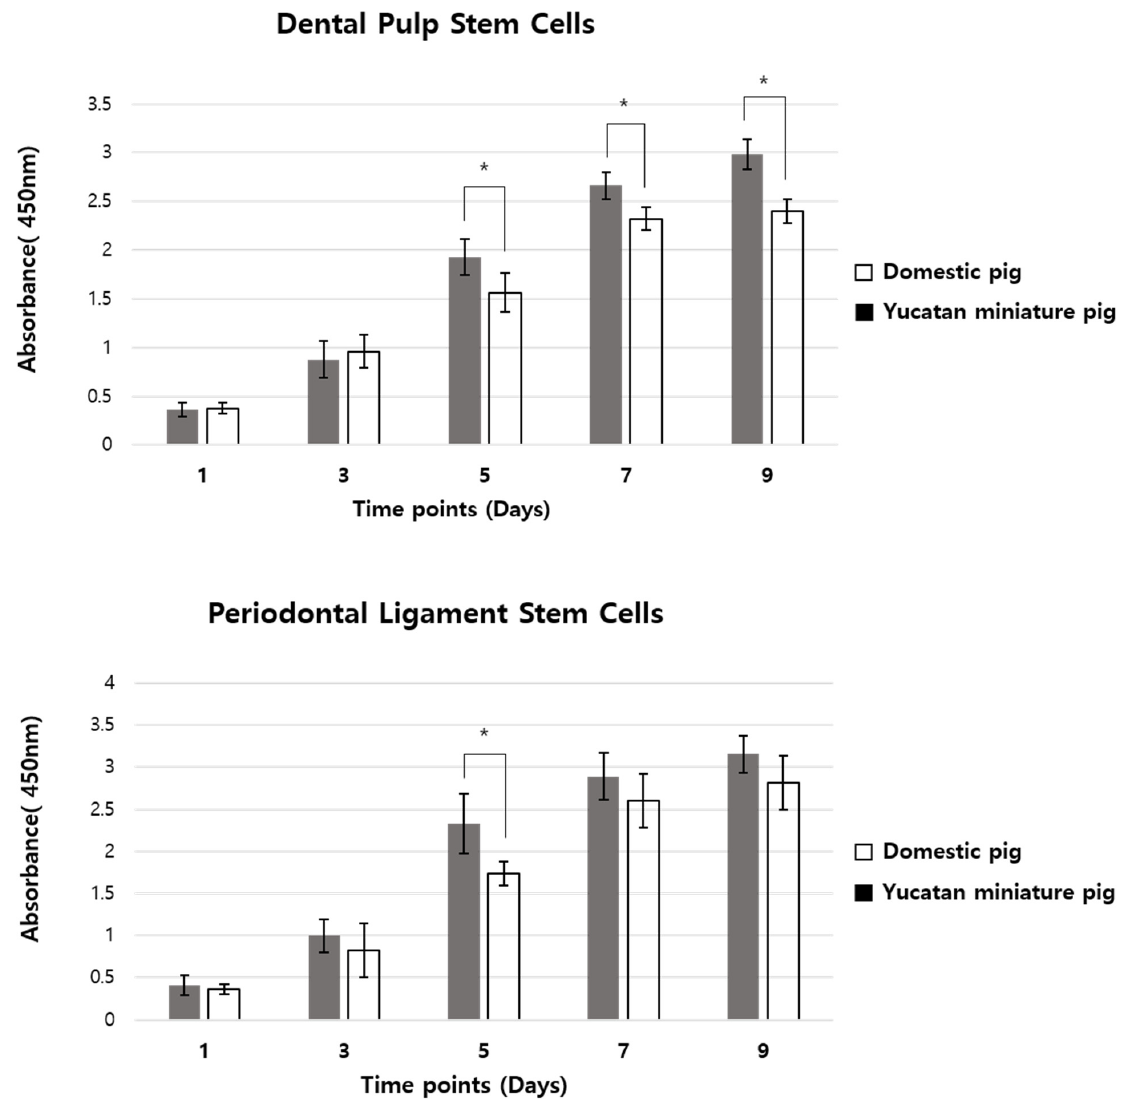
Figure 4. The proliferation of the dental pulp stem cells (DPSCs) and periodontal ligament stem cells (PDLSCs) of the miniature pig breed and the domestic farm pig breed after 1, 3, 5, 7, and 9 days of culturing in the CCK-8 assay. The DPSCs of the miniature pig breed showed significantly higher absorbance than those of the domestic farm pig breed at five days of culturing ( p < 0.05). On the other hand, the PDLSC results showed no significant difference between the pigs in the study, except after five days of culturing (* p <